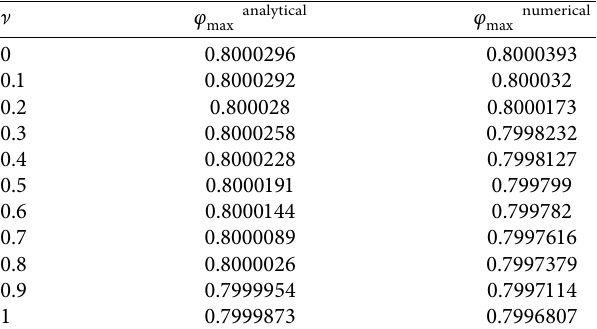
Figure 9: The numerical solutions for case (iii) in Section 4.1. Table 4: φ of the fourth case ( Ω � 1 . 5 , μ � 1250 ) . max